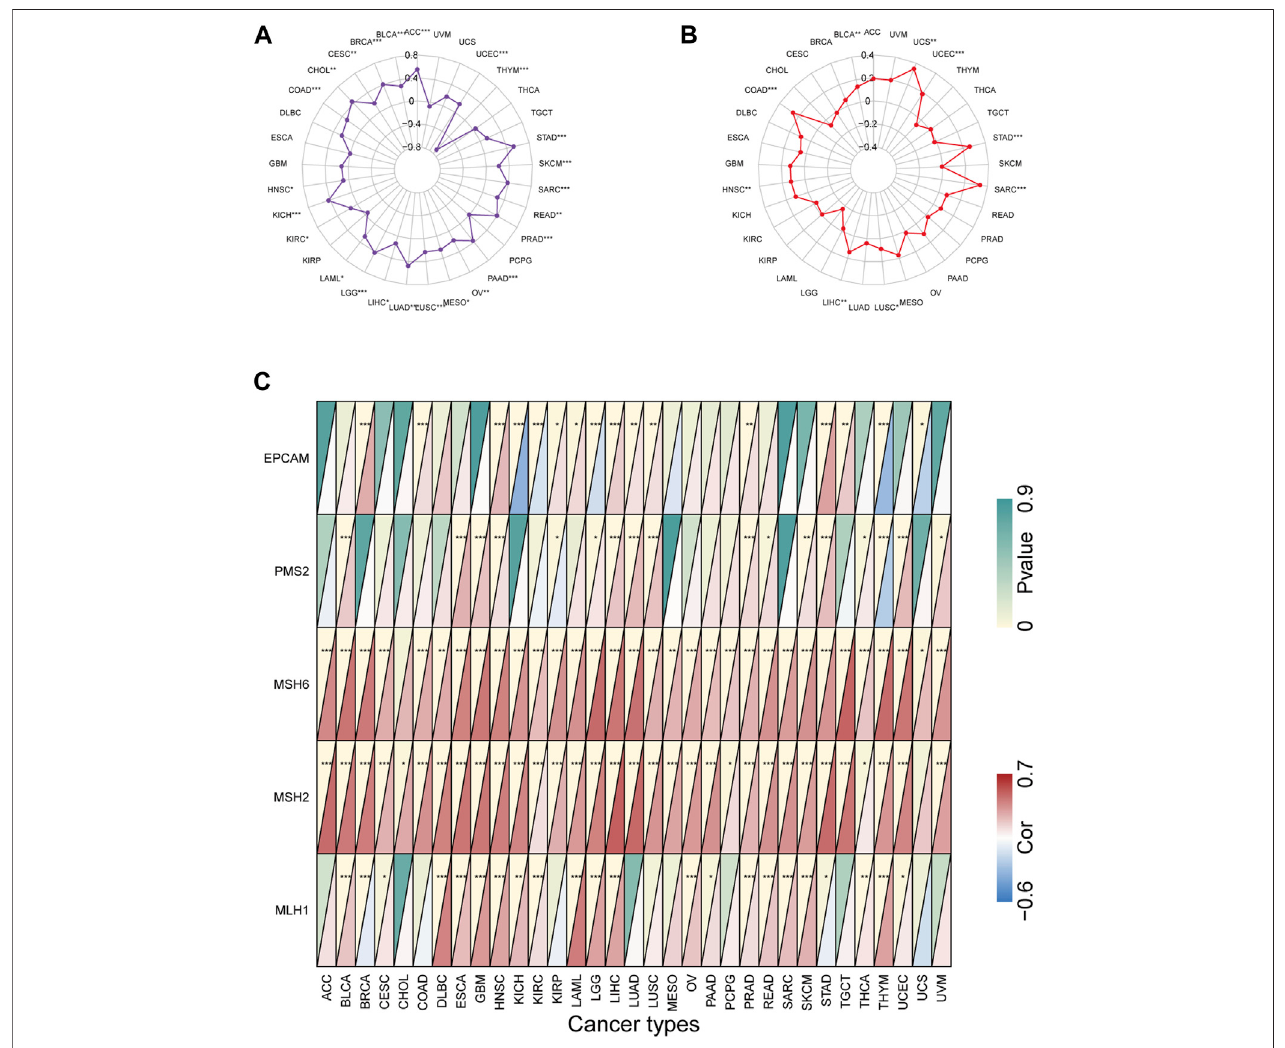
FIGURE 3 | Correlation of KIF2C expression with tumor mutation burden (TMB), microsatellite instability (MSI), and mismatch repairs (MMRs) in pan-cancer (A) RadarmapshowscorrelationofKIF2CexpressionwithTMBinpan-cancer. (B) RadarmapshowscorrelationofKIF2CexpressionwithMSIinpan-cancer. (C) Heatmap shows correlation of KIF2C expression with 5 MMRs related genes in